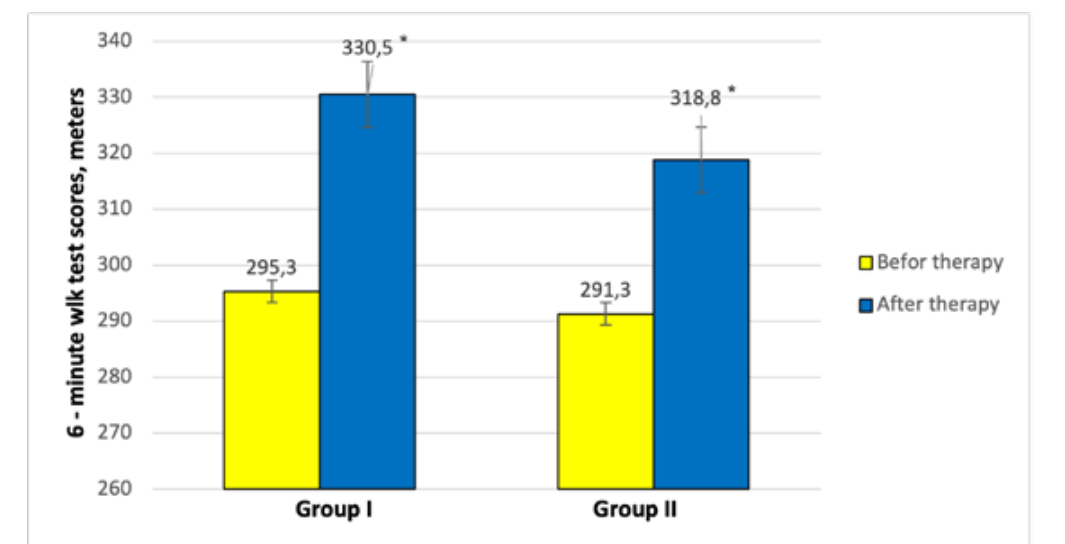
Figure 2. Changes in 6 – minute walk test scores in group I treated with physiotherapy and in group II subjects treated with dance and movement therapy. Statistical significance *p < 0.05